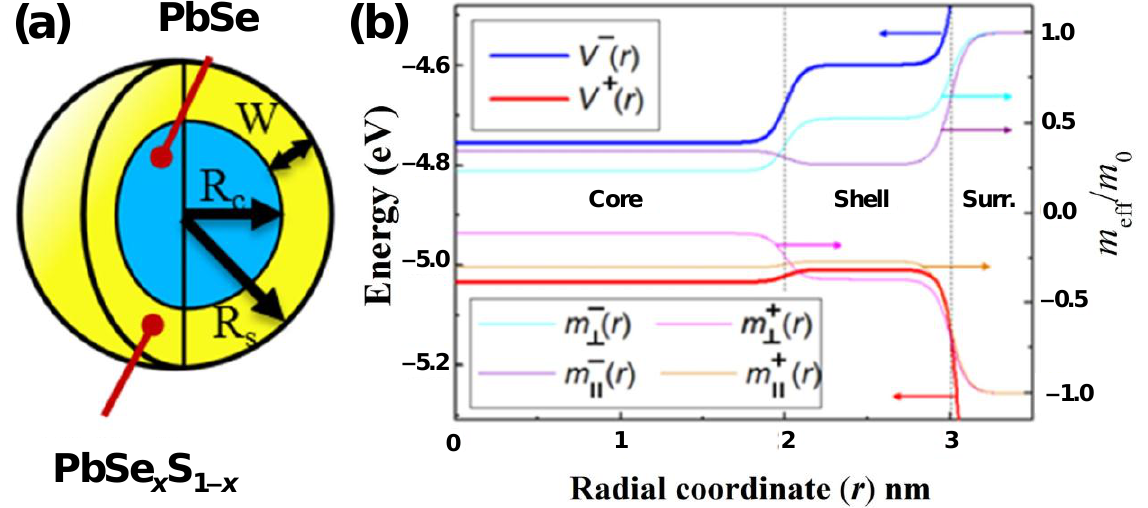
Figure 2. ( a ) Schematic representation of a QD heterostructure with alloyed-shell composition and general chemical formula PbSe/PbSe x S 1– x , where 0 ≤ x ≤ 1. R c and R s are the core and shell radius, respectively, and W is the shell thickness; ( b ) P lot of the conduction and valence band-edge energies, V −/+ (left axis), and the remote band contributions to the valence and conduction band effective masses, m free electron mass, m 0 (right axis), vs. the radial coordinate in the heterostructure shown in ( a ), with R c = 2 nm and Rs = 3 nm. The zero energy is taken at the vacuum